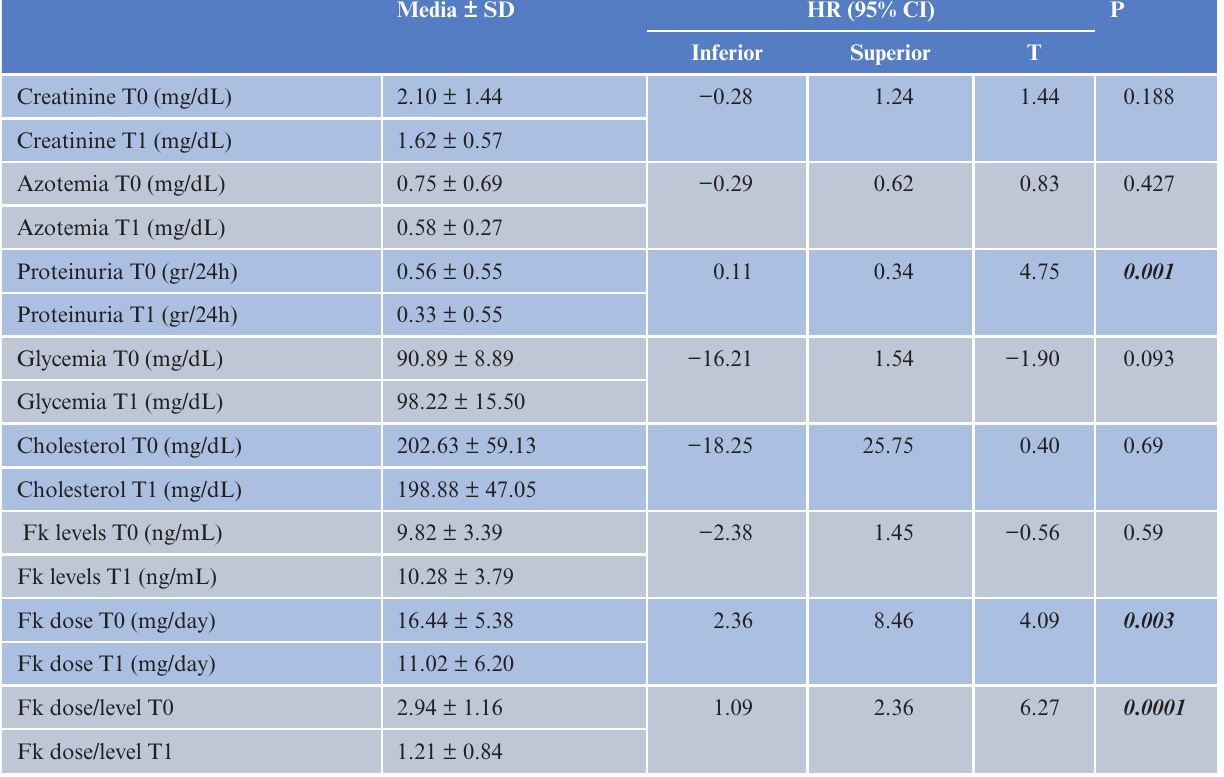
Table 1. In the left colon parameters are presented at the time of the switch (t0) and after 1 month (t1) Media ± SD HR (95% CI) P Inferior Superior